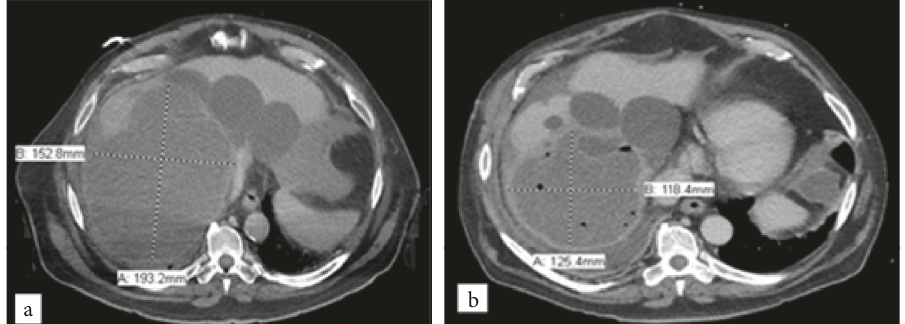
Figure 4: Computed tomography scan before starting antimicrobial therapy in Patient 4 demonstrates a dominant internally complex cyst in the right hepatic dome measuring 15.3 × 19.3cm (a). Computed tomography at time of antimicrobial completion shows the cyst in the dome of liver with interval decrease in size after placement of drainage catheters, now measuring 11.8 × 12.5cm